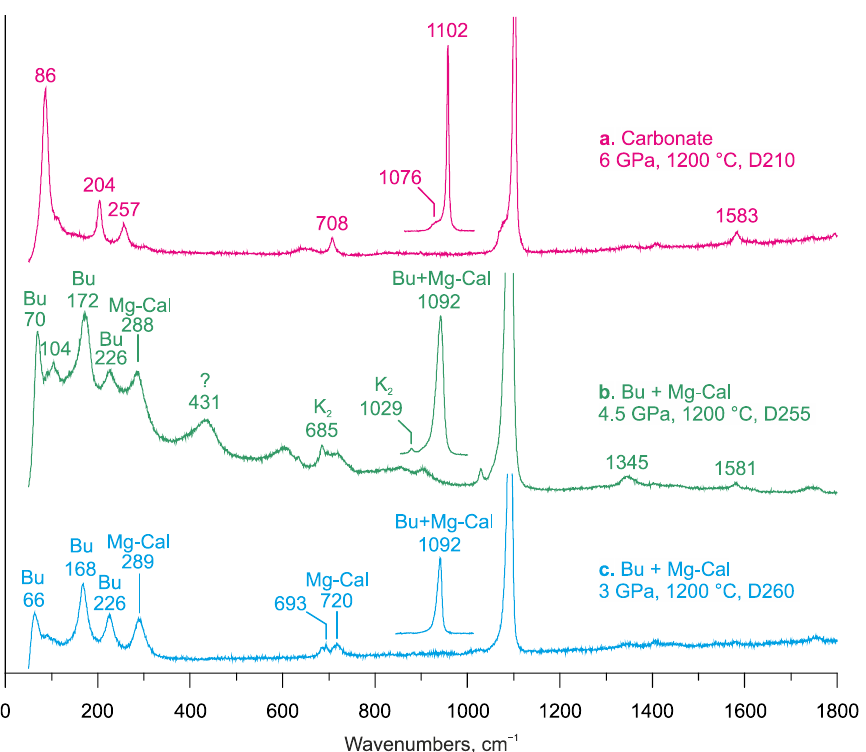
Figure 13. Representative Raman spectra of carbonate melt quench products in the system L(S) + L(C). ( a ) run D210 at 6 GPa and 1200 °C, ( b ) run D255 at 4.5 GPa and 1200 °C, and ( c ) run D260 at 3 GPa and 1200 °C.